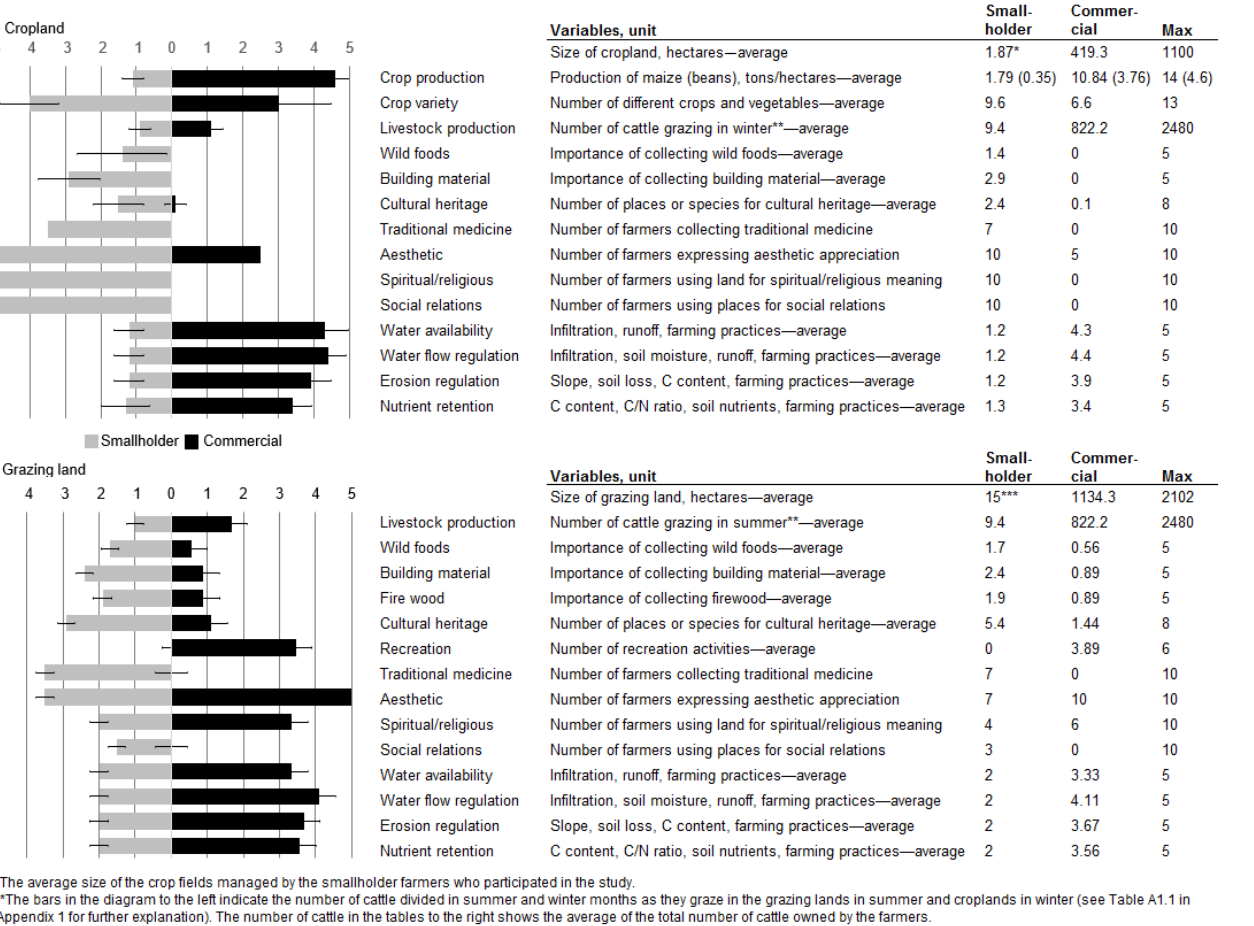
Fig. 2 . The supply of ecosystem services in smallholder and commercial agricultural land uses, cropland (a) and grazing land (b). The diagrams to the left show normalized values relative to 5, including standard deviation for categorical values. The tables on the right show the actual values and maximum values for each